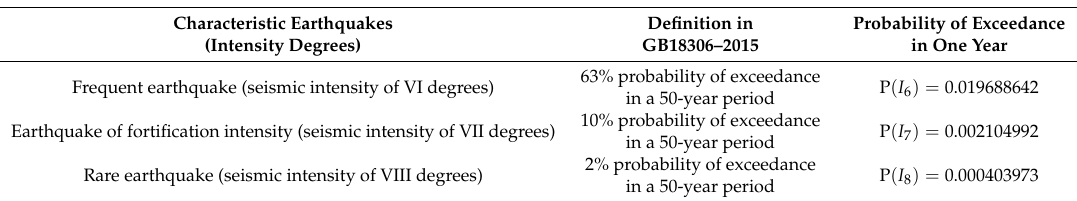
Table 2. Annual probabilities of three characteristic earthquakes occurring in a one-year period in